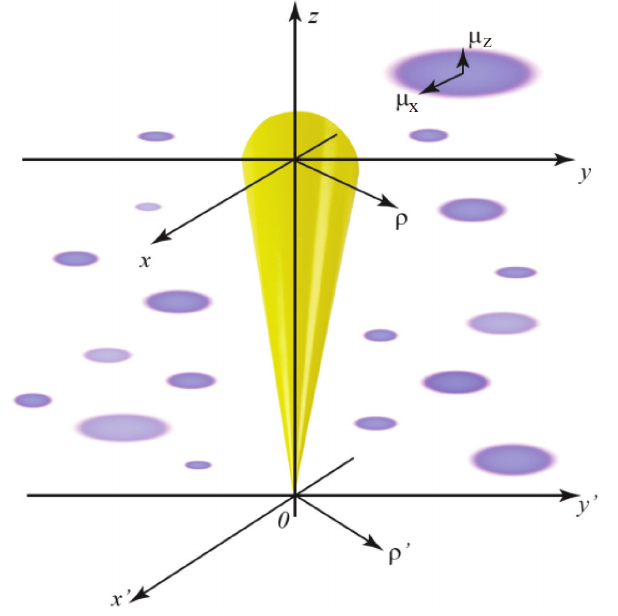
Figure 9. Anisotropic turbulence. Vertical case. Vectors ρρρ (cid:48) = x (cid:48) ˆ x (cid:48) + y (cid:48) ˆ y (cid:48) and ρρρ = x ˆ x + y ˆ y are 2D position vectors of points in the source and in the field planes.